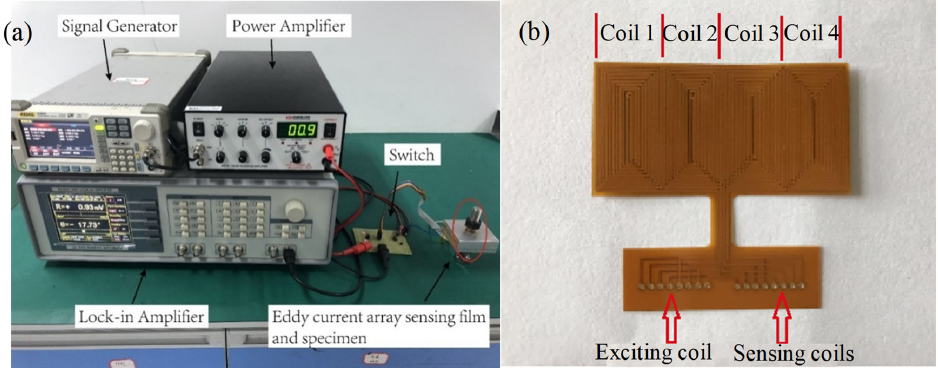
Figure 11. Experimental setup and sensor. ( a ) Experimental setup; ( b ) The sensing film.